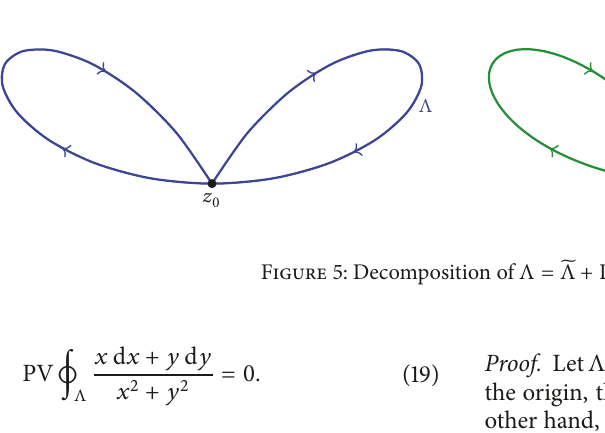
Figure 4: Winding number of Λ .